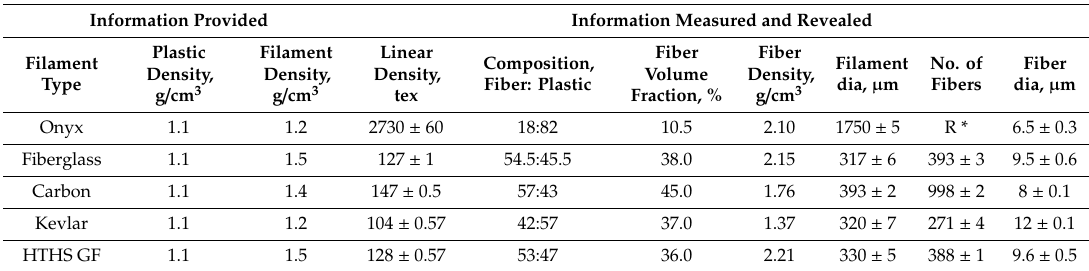
Table 2. Specifications of fiber filament.